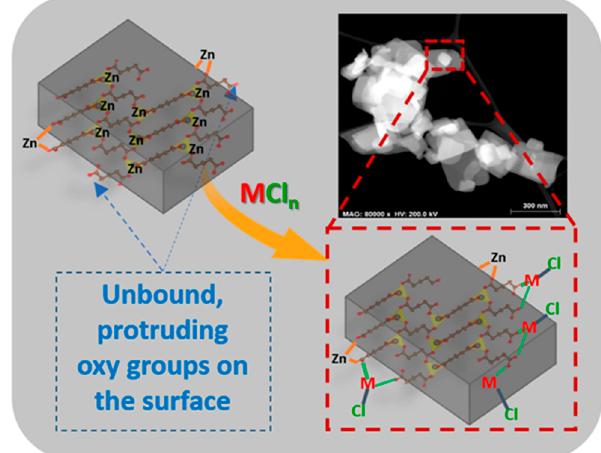
Figure 1. Schematic representation of the formation of ZnGA-M.